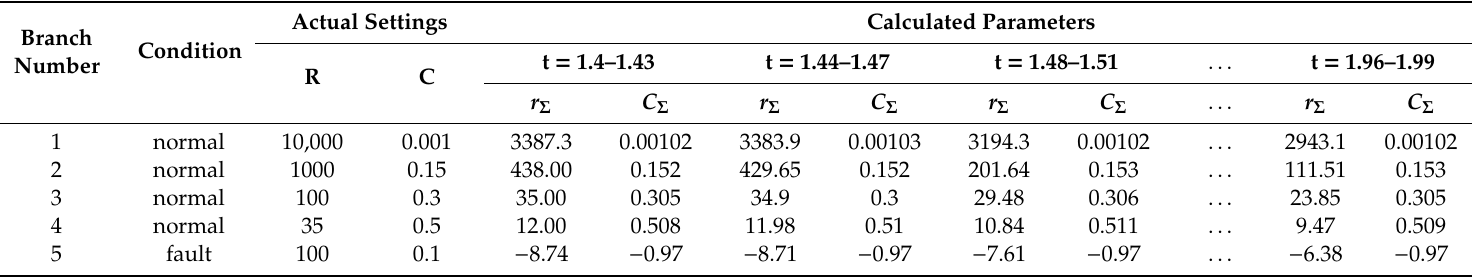
Table 2. The result of the emulate when the extreme circumstance of single-phase earth leakage fault occurred ( R g = 1000 Ω ). (resistance: k Ω ; capacitance: µ F; time: ms).